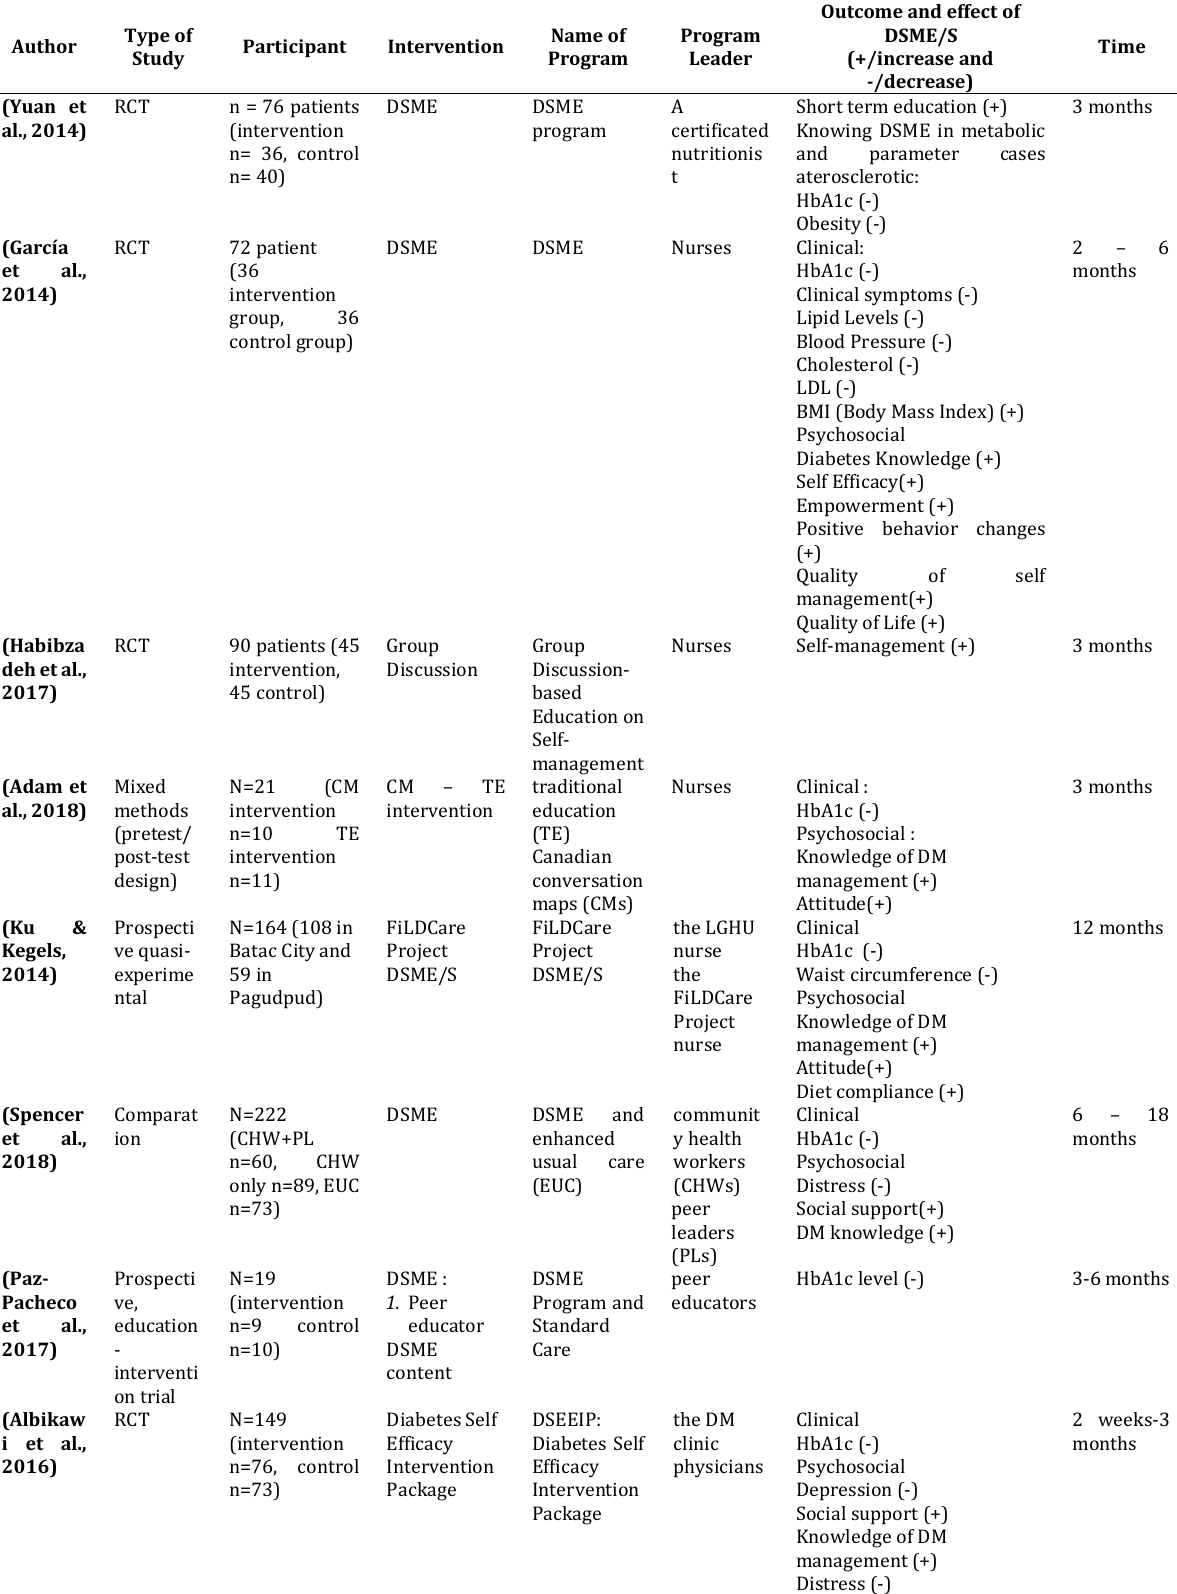
Table 2. Experimental Studies and RCTs of DSME/S type 2 diabetes mellitus as the basis of the systematic review